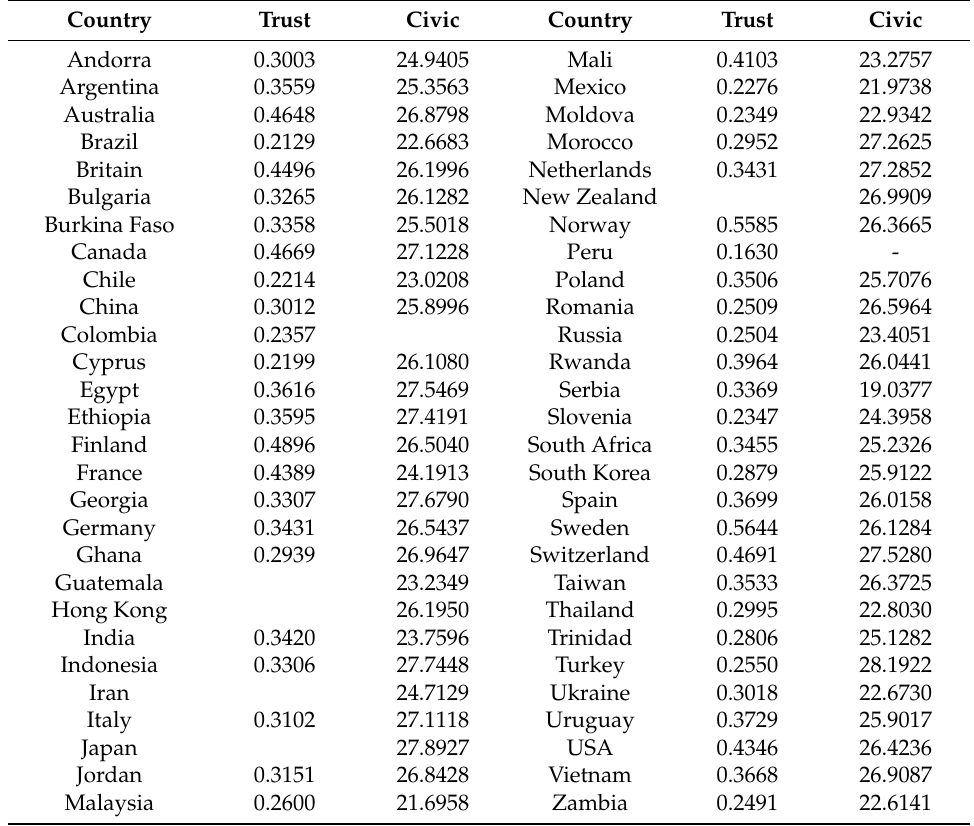
Table A2. List of Trust and Civic by country in